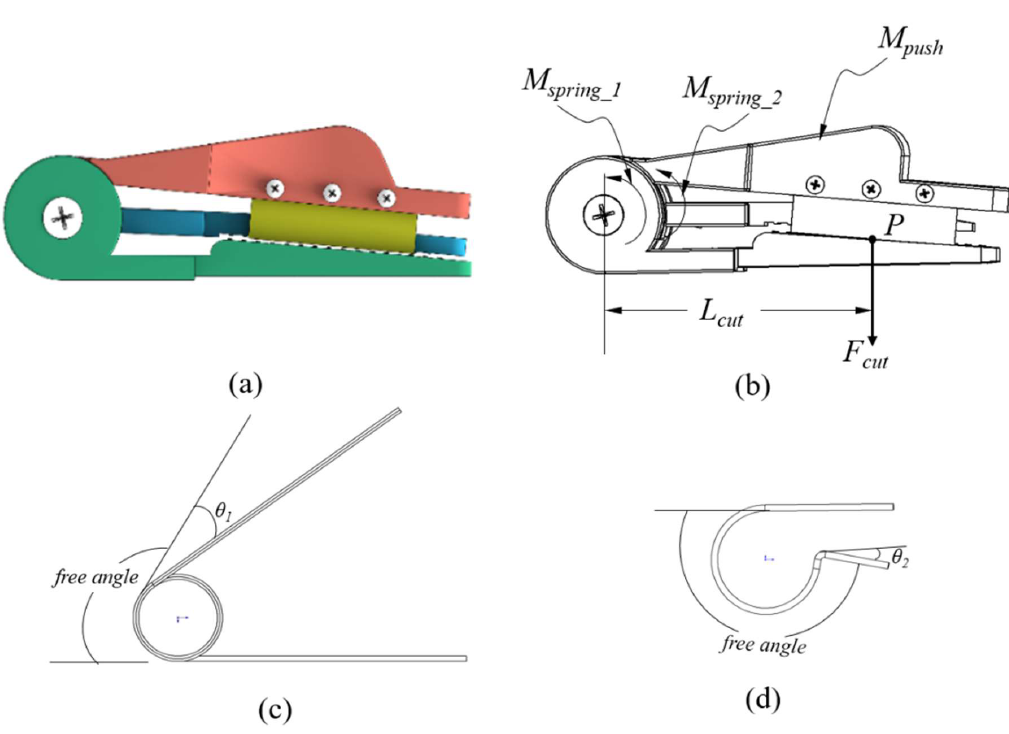
Figure 4. Force diagram of the cutting blade touching the bottom plate. ( a ) The diagram of the gripper. The force analysis of the gripper ( b ), Torsion spring 1 ( c ), and Torsion spring 2 ( d ). Sensors 2019 , 19 , x FOR PEER REVIEW